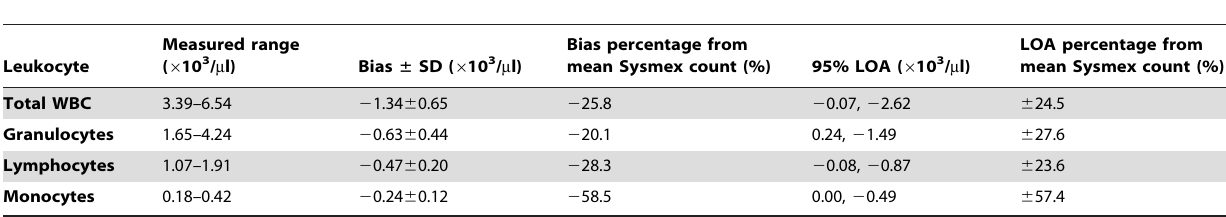
Table 3. Bland-Altman parameters for concordance between fingerprick samples measured on standard analyzer and MIC.